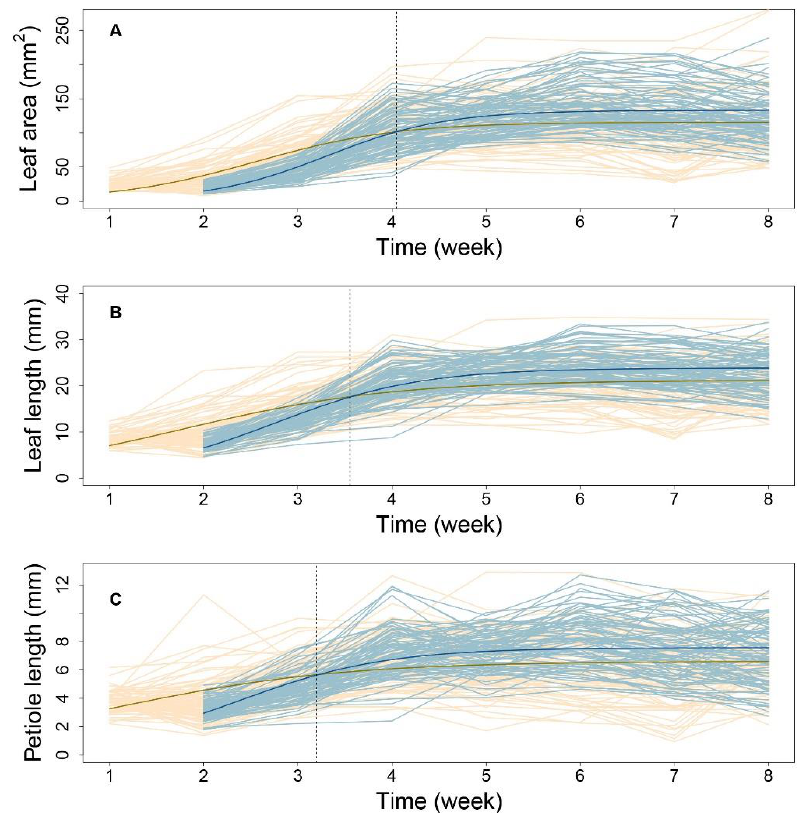
Figure 2. Dynamic growth pattern of leaf traits under high-density and low-density conditions. (A)-(C) , respectively, present the ontogenic growth curve of the leaf area, leaf length, and petiole length. Yellow curves denote trait patterns from a low-density environment while blue curves denote that from a high-density environment. The two thick lines represent the fitted mean growth curve, while thin lines represents the observed growth phenotype with each progeny in the population. The vertical line indicates the timepoint when the two mean curves for the two densities crossed.